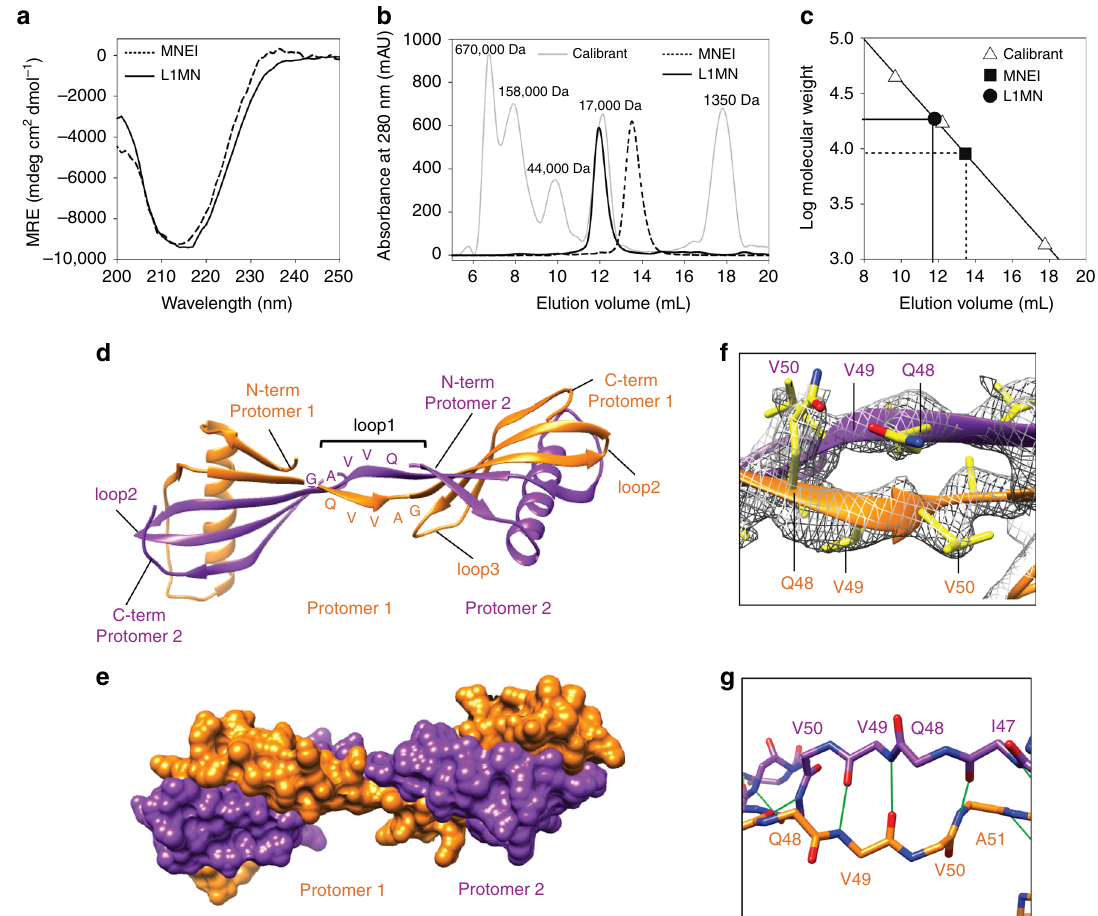
Fig. 2 QVVAG segment from ste fi n B drives domain swapping in L1MN. a Far-UV CD spectra of wt MNEI and L1MN are shown. b Size exclusion pro fi les of wt MNEI and L1MN, at pH 7, are shown. The pro fi le of the calibration mix (marker) is shown in gray. c Plot of the logarithm of molecular weight vs. elution volume generated using the elution pro fi le of the calibration mix in (b) is shown. The data were fi tted to a straight line ( r = 0.99), and the apparent molecular weights of wt MNEI ( ■ ~10 kDa) and L1MN ( ● ~20 kDa) were determined. d Structure of the L1MN domain-swapped dimer is shown. Two polypeptide chains contributing to the swapped dimer (protomers) are shown in orange and purple. The N-termini and C-termini, and different loops of both the polypeptide chains contributing to the swapped dimer are indicated, except for loop3 of protomer 2, which is not clearly visible in the orientation depicted. e A space- fi lling model of the L1MN domain-swapped dimer is shown to highlight the quaternary arrangement of the protomers. f Zoomed in view of the hinge loop from d , showing the QVVAG stretch within the electron density map. The 2Fo-Fc simulated anneal composite omit map is shown at a contour level of 1.6 σ . Side chain nitrogen atoms are colored blue, and oxygen atoms are colored red. All other side chain atoms are colored yellow. g The backbone trace of the hinge region is shown, and the backbone hydrogen bonds formed in the hinge region are shown by green lines. Source data are provided as a Source Data fi